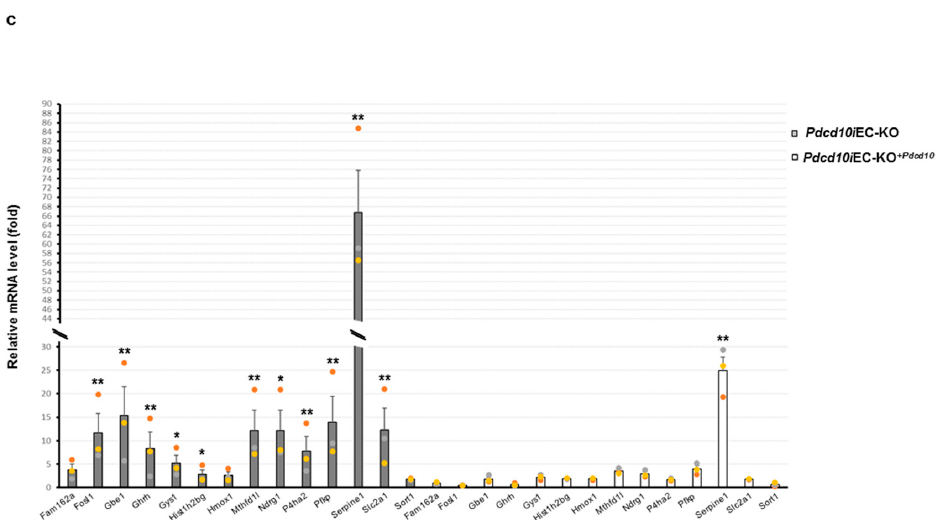
Figure 3. RNA-seq validation analysis. ( a ) Q-PCR results of a set of DEGs in siPdcd10-ECs and siCNT-EC. The fold change value relates to the mean expression levels of siCNT-EC, which were set as value 1. The mean expression levels of siCNT-EC derived from three biological replicates; each of these was run in three technical replicates. Graphs show averages calculated on three different biological experiments represented by three points (green, yellow and orange); each point characterized the mean of three technical replicates. Error bars represent standard errors. Values are expressed as mean +/ − SEM (** p < 0.01, n = 3). ( b ) Q-PCR of Pdcd10 expression level of mouse (left) and human (right) gene results came from Pdcd10iEC-KO, EC-Ctrl, and Pdcd10iEC-KO +Pdcd10 cell lines. ( c ) Q-PCR of some DEGs came from Pdcd10iEC-KO, EC-Ctrl and Pdcd10iEC-KO +Pdcd10 lines were reported. Graphs show averages calculated on three different biological experiments represented by three points (green, yellow and orange); each point characterized the mean of three technical replicates. The fold change value relates to the mean expression levels of EC-Ctrl, which were set as value 1. The mean expression levels of EC-Ctrl derived from three biological replicates; each of these was run in three technical replicates. Values are expressed as mean +/ − SEM (** p < 0.01, * p < 0.05, n = 3).